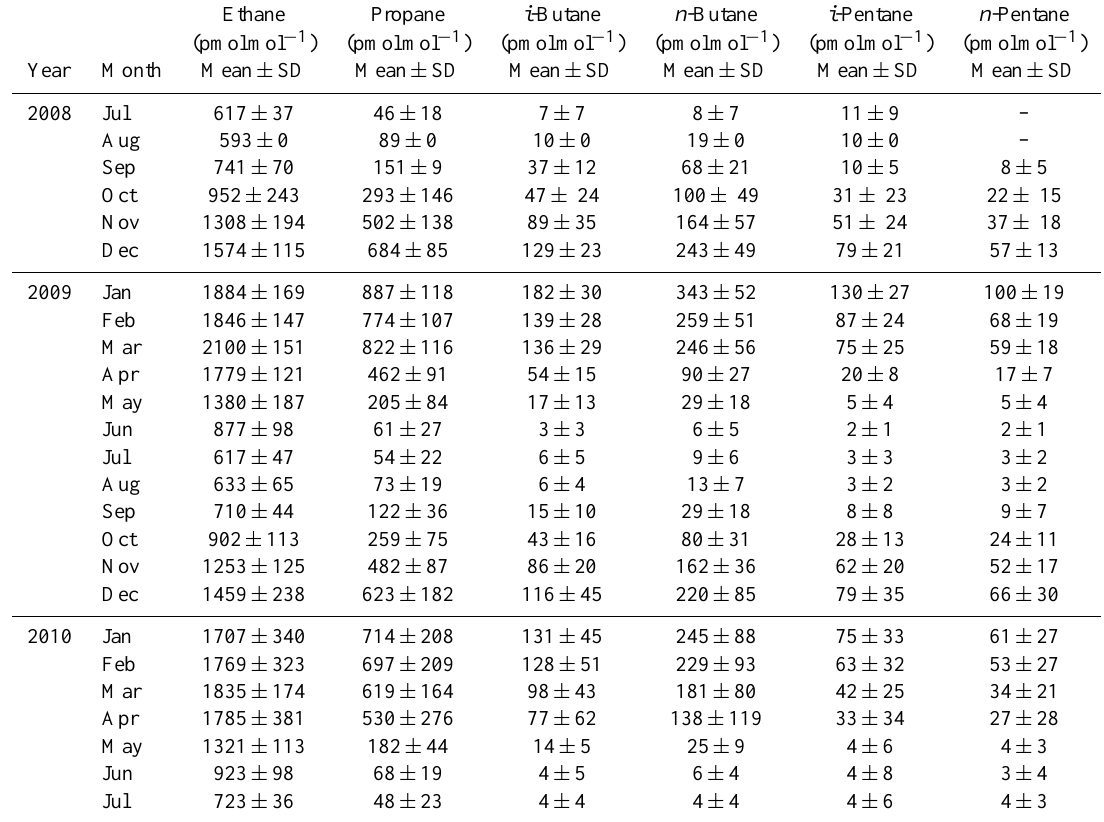
Table 2. Monthly statistics for NMHC measured at Summit from 2008 to 2010. Ethane Propane i